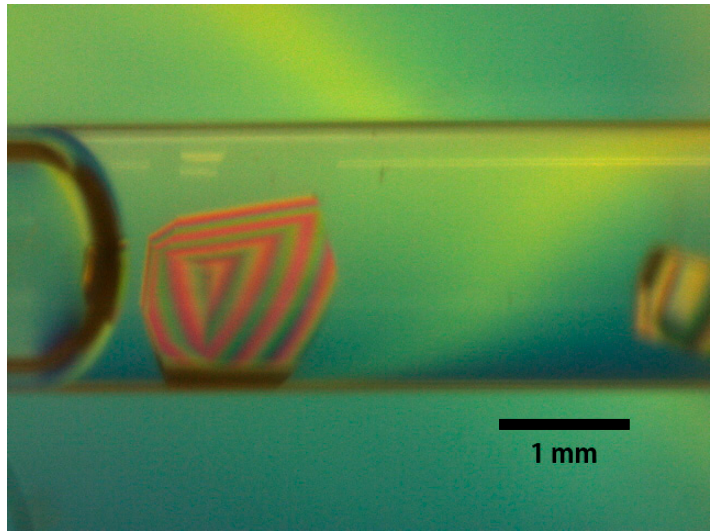
Figure 3. Lysozyme crystals grown in the crystallization cell. The crystal was approximately 1.8 mm on its longest side.